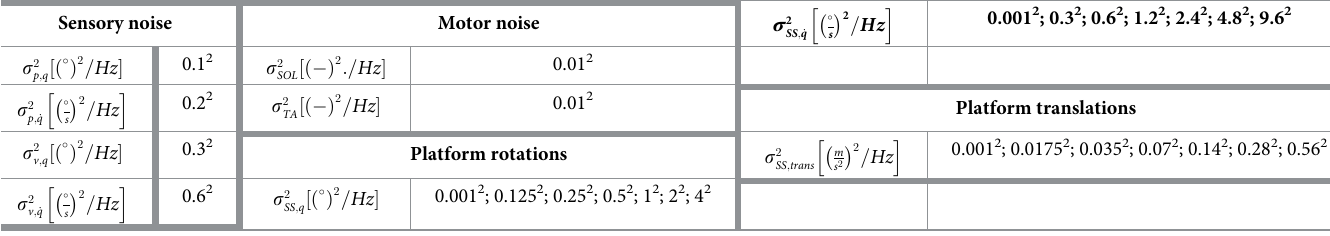
Table 2. Noise characteristics for perturbed standing balance